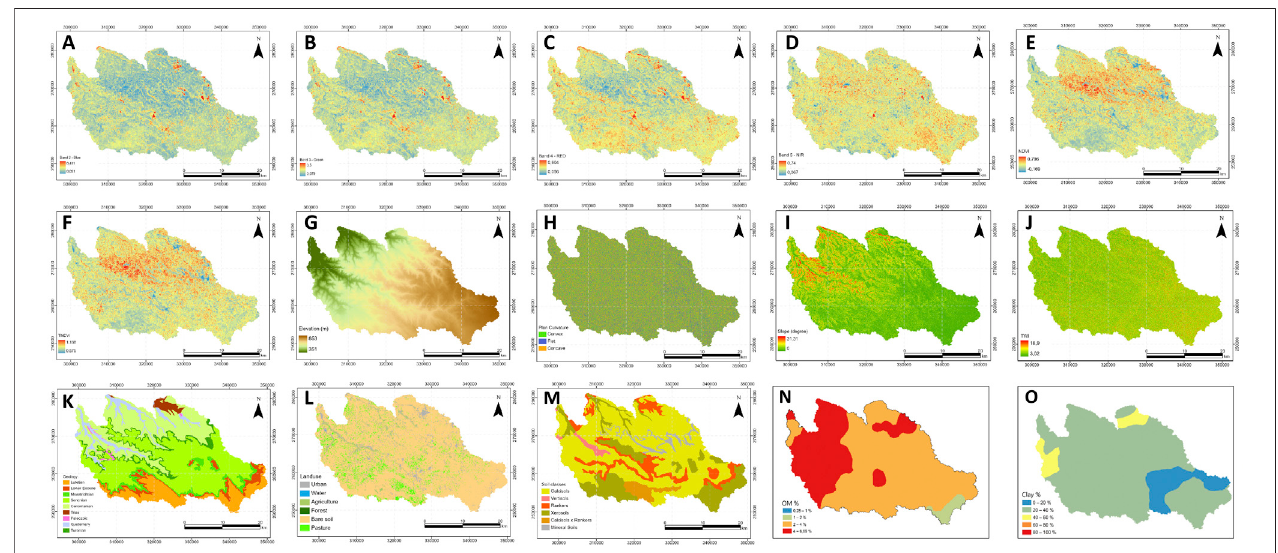
FIGURE 2 | Conditioning factors used for soil aggregate stability mapping. (A) Band-2 Blue, (B) Band-3 Green, (C) Band-4 Red, (D) Band-5 NIR, (E) NDVI, (F) TNDVI, (G) Elevation, (H) Plan curvature, (I) Slope, (J) TWI, (K) Geology, (L) Landuse, (M) Soil classes, (N) Organic matter and (O) Clay.